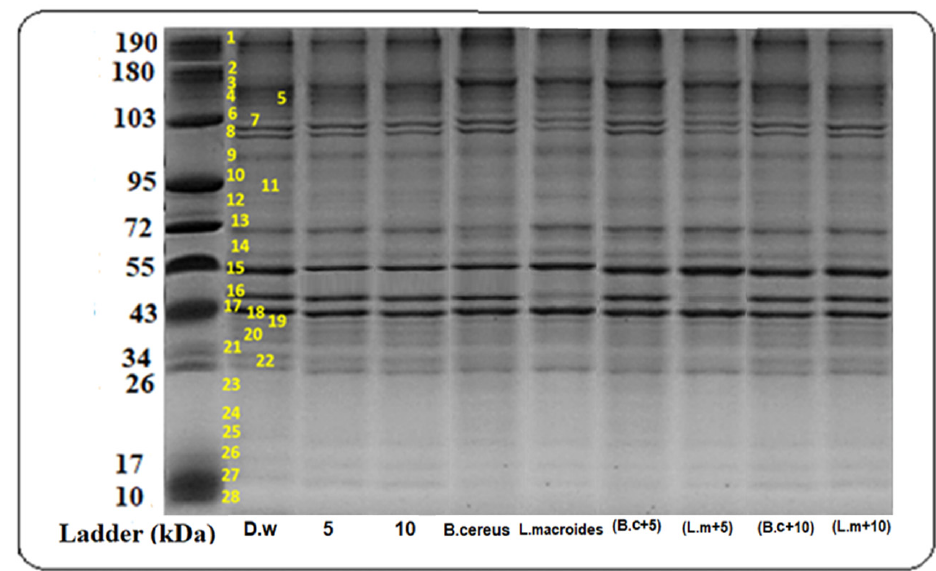
Figure 1. Protein banding profiles were detected on SDS-PAGE with CBB staining of rice plants that were grown by the synergistic treatment of seeds that were primed with bacteria and grown in ZnO NPs alone or in combination with distilled water. (Lane 1: DW (distilled water), Lane 2: Bio-priming with Bacillus cereus , Lane 3: Bio-priming with Lysinibacillus macroides , Lane 4: 5 mg/L ZnO NPs treatment, Lane 5: 10 mg/L ZnO NPs treatment, Lane 6: Bacillus cereus + 5 mg/L ZnO NPs, Lane 7: Lysinibacillus macroides + 5 mg/L ZnO NPs, Lane 8: Bacillus cereus + 10 mg/L ZnO NPs, Lane 9: Lysinibacillus macroides + 10 mg/L ZnO NPs).